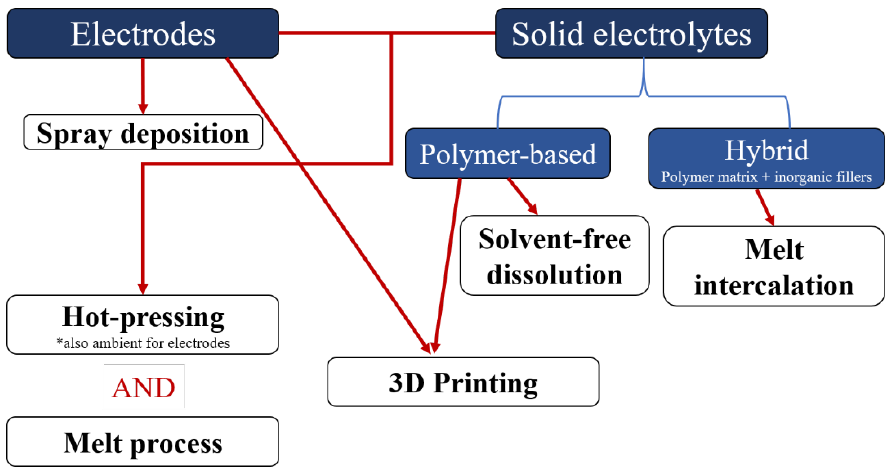
Figure 1. Flow chart summarizing the different solvent-free processes recently developed to make electrodes and/or solid electrolytes for lithium-ion batteries.